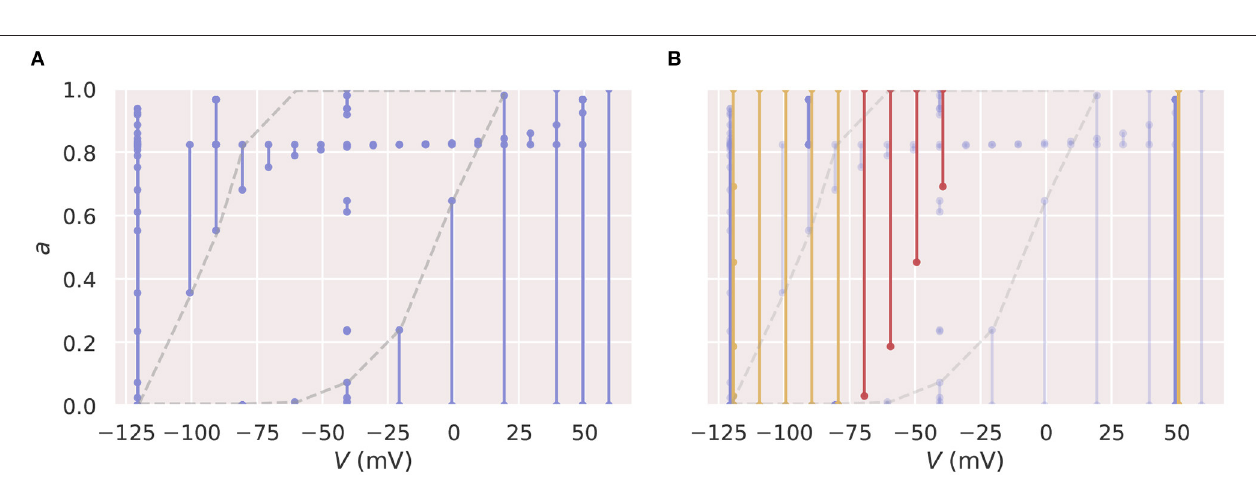
FIGURE 8 | Two-dimensional state spaces illustrating the inappropriate training protocol for a neural ODE. The lines on these diagrams indicate states occupied at some point in time in simulations using the candidate model, with a dot for the state at the start and end of each voltage step. (A) Shows the state space spanned by the Pr3 and Pr4 training protocols (blue). The grey dashed line highlights a large region of very sparse training data. (B) The same state space with trajectories required by the prediction protocol, Pr5, highlighted (orange and red). The sections highlighted in red in Figure 7 with very bad predictions are also shown in red here. It is evident that the neural ODE makes “bad” predictions when extrapolating into the centre of the sparse region of training samples. All figures with red backgrounds are trained on Pr3/Pr4.